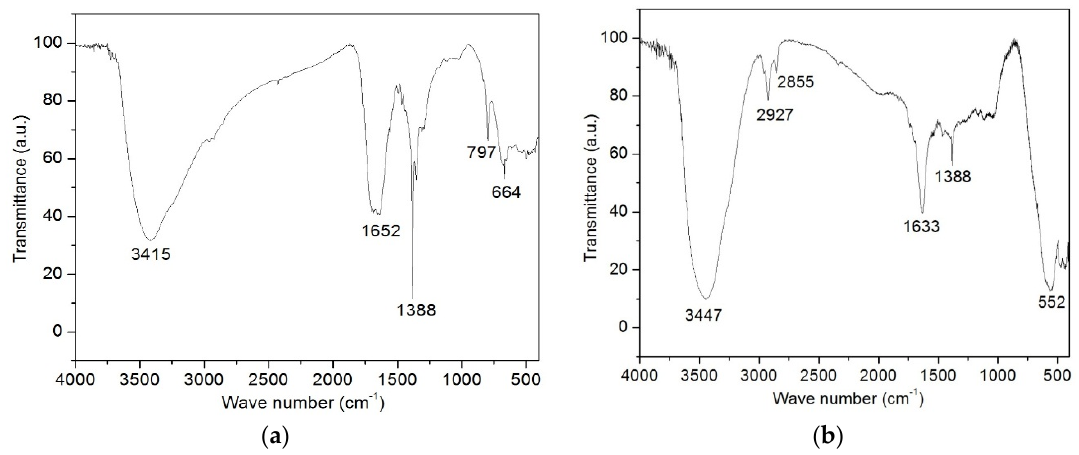
Figure 2. ( a ) Fourier transform infrared spectroscopy (FTIR) spectra of copper ferrite powder calcined at 150 °C for 24 h; ( b ) FTIR spectra of zinc ferrite powder calcined at 150 °C for 24 h.